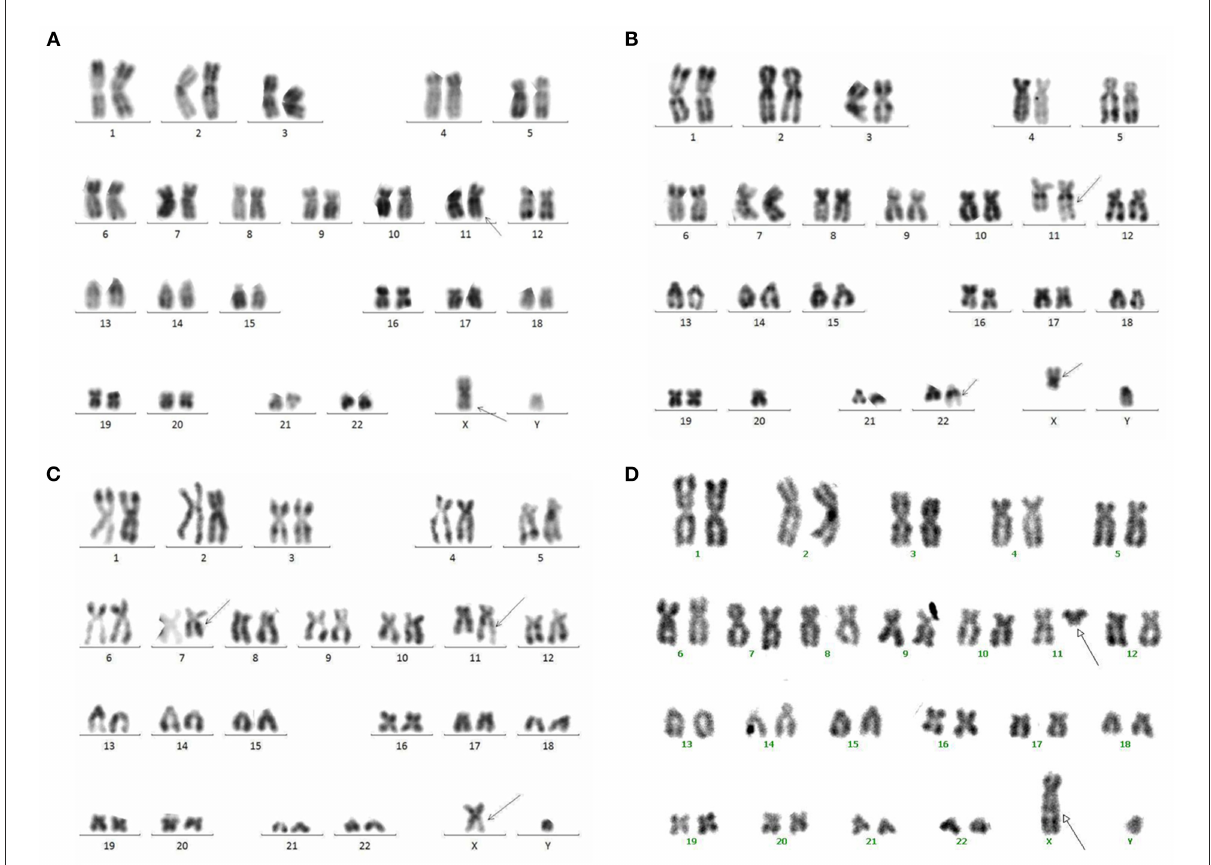
FIGURE3 Karyotype analysis results of bone marrow. (A–D) represent cases 1, 2, 3, and 4,